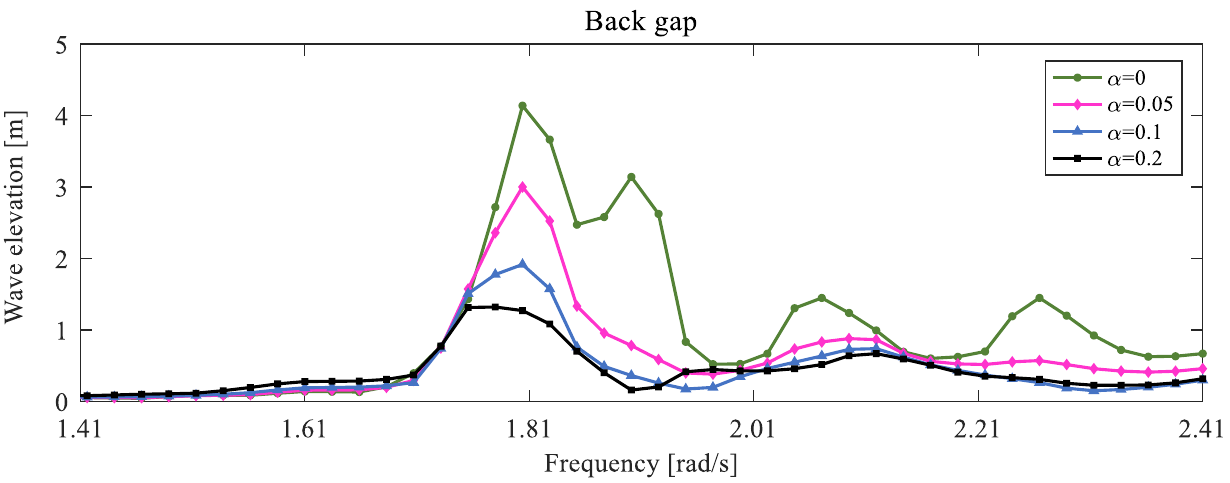
Figure 11. Free surface elevation in the back gap under different artificial damping ratios.